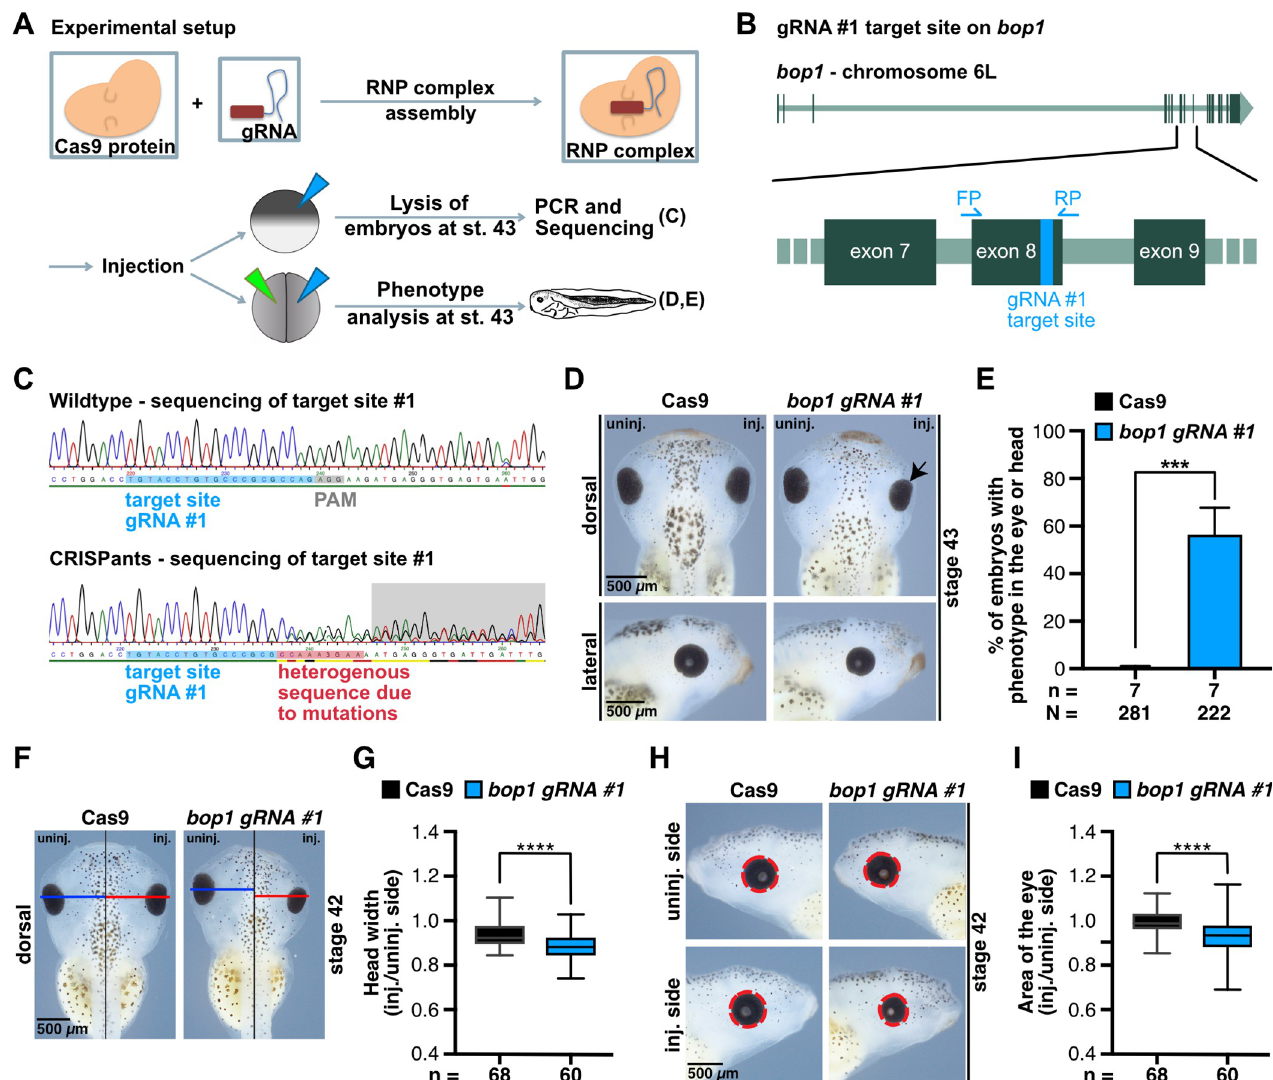
Fig 5. bop1 knockout using the CIRSPR/Cas9 system. A Experimental setup of CRISPR/Cas9 gene editing experiments. Cas9 protein was pre-assembled with bop1 gRNA #1 to build ribonucleoprotein (RNP) complex. Embryos were injected at one-cell stage for sequencing analysis. Embryos were injected at two-cell stage for phenotypic analysis. B Target site of gRNA #1 on bop1 exon 8. Here shown for chromosome 6L –off note, there are no mismatches between target site on homeologue L and S. C DNA pools of 10 wildtype embryos or 10 bop1 CRISPants were sequenced. Target site of bop1 gRNA #1 is highlighted in blue, protospacer adjacent motif (PAM) sequence in grey, and heterogenous sequence in CRISPants DNA pool in red. CRISPR/Cas9 system successfully introduced mutations. D Injection of bop1 gRNA #1 resulted in smaller eyes (indicated with black arrow) and smaller heads on the injected side, whereas injection of Cas9 protein alone did not affect anterior development. E Statistical analysis of data shown in D. F The head width of the injected side (red line) was compared to the width of the uninjected side (blue line). Black line indicates the midline of the embryo. G Knockout of bop1 led to significantly narrower heads on the injected side. H Area of the eye on the injected side was compared to the area of the eye on the uninjected side. Measured area is indicated by red dotted line. I bop1 CRISPants showed a significantly reduced eye area. Cas9 protein alone did not affect the area of the eye. Abbreviations: bop1 gRNA #1 , block of proliferation 1 guide RNA #1; Cas9, CRISPR-associated protein 9; CRISPR, clustered regularly interspaced short palindromic repeats; inj., injected side; n, number of independent experiments; N, number of injected and analyzed embryos; PAM, protospacer adjacent motif; PCR, polymerase chain reaction; RNP, ribonucleoprotein; uninj., uninjected side. Error bars indicate standard error of the means; Whiskers in G and H indicate minimum and maximum. ��� , p � 0.001; ���� , p �